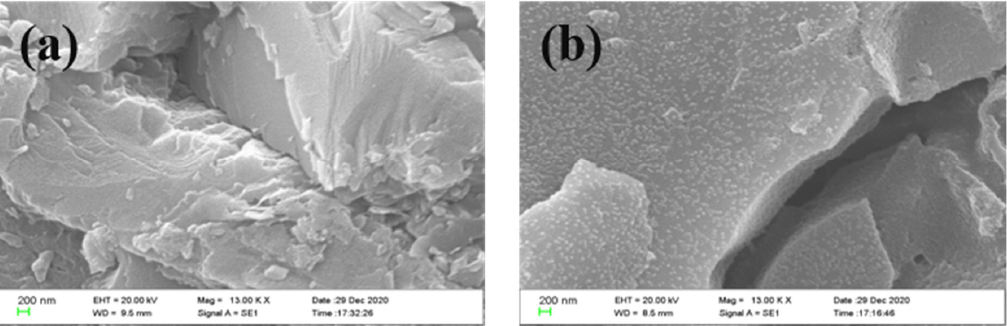
Figure 7. ( a ) The surface morphologies of the core before the nano ‐ emulsion treatment. ( b ) The surface morphology of the core after the nano ‐ emulsion treatment.